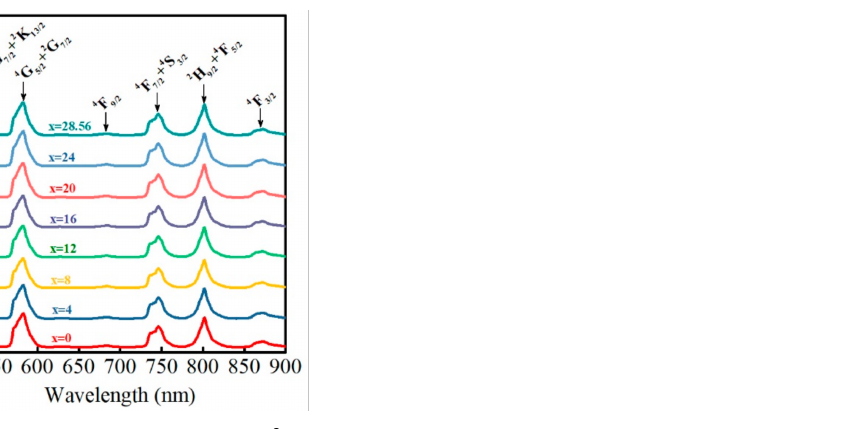
Figure 6. Absorption spectrum of Nd 3+ ions in PKNi glass with different Na/(Na+K) ratios between 500–900 nm. Table 3. The J–O parameter, emission cross-section, radiation lifetime, fluorescence lifetime, radiation transition probabilities (A), effective bandwidth, fluorescence branching ratios, quantum efficiency of Nd 3+ ion at 1053 nm in PKNi glasses with different Na/(Na+K)